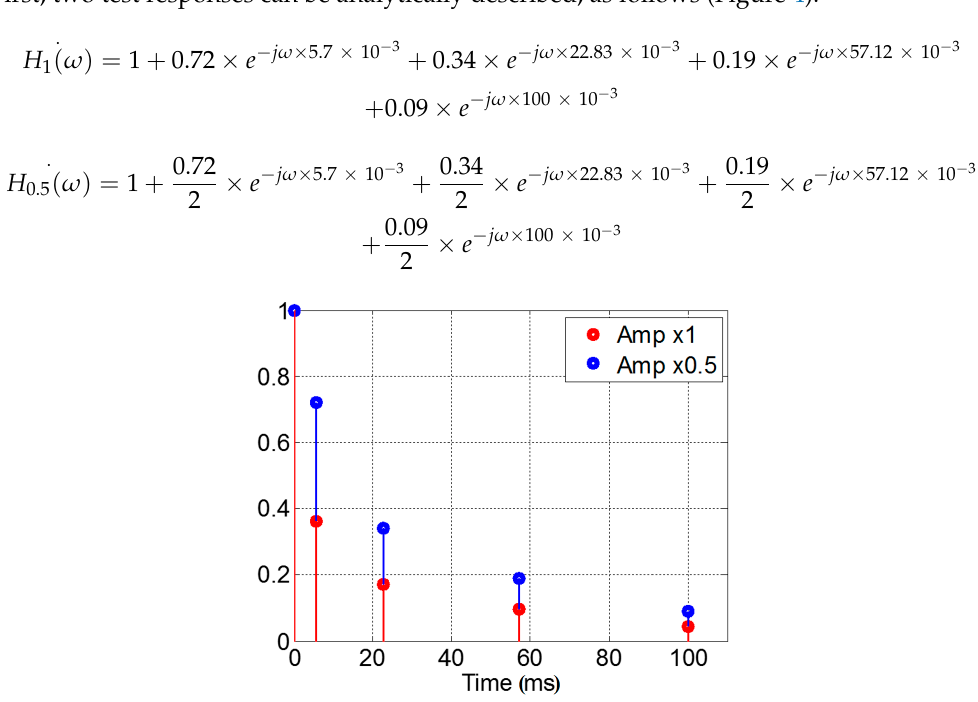
Figure 3. Results of the bit error rate (BER) (signal-to-noise ratio (SNR)) ratio modeling under AWGN conditions.